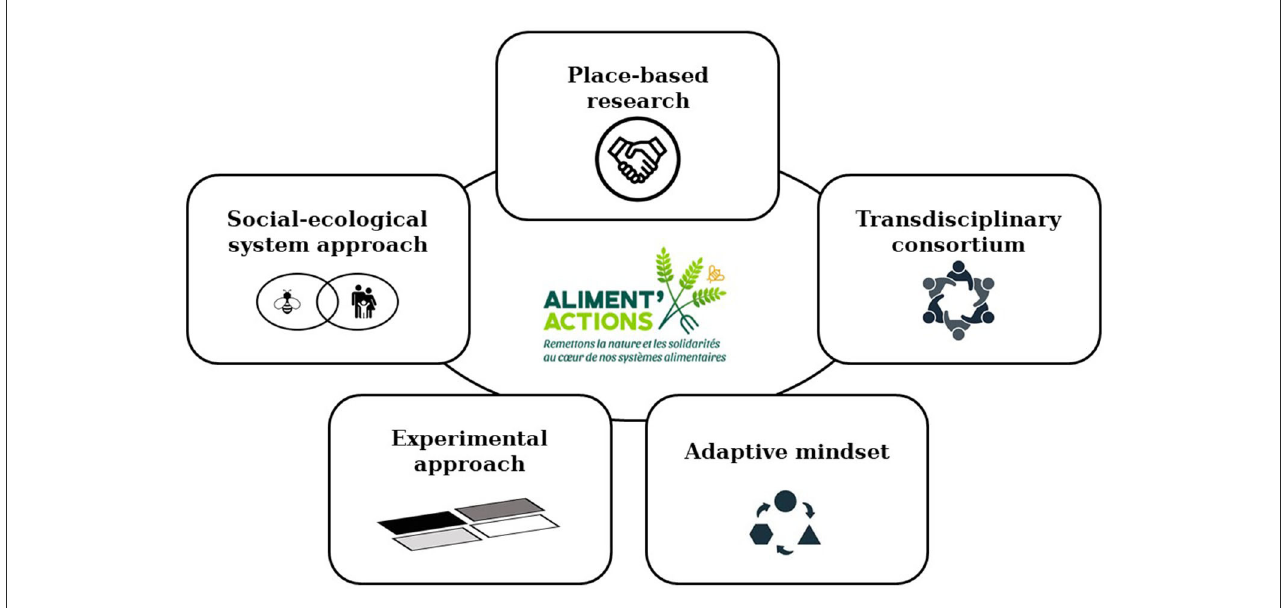
FIGURE2 The main features of the Aliment’Actions